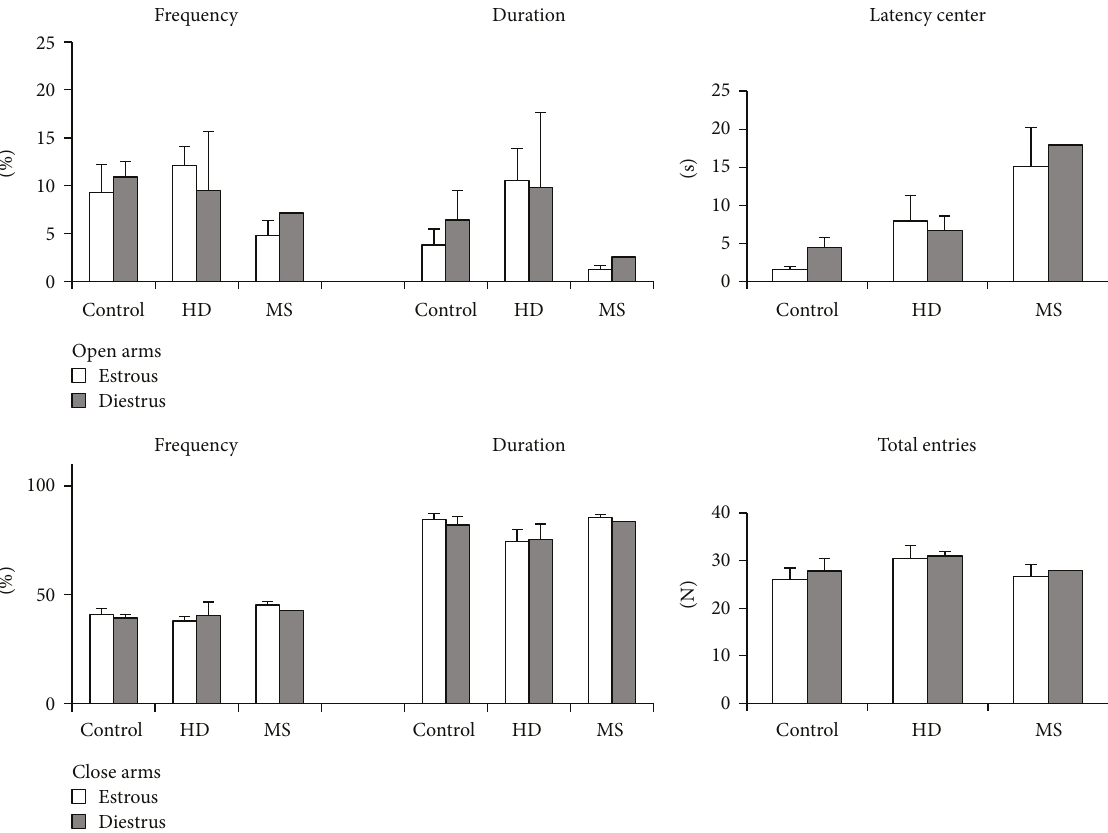
Figure 3: The in fl uence of early-life stress on the behavior of adult female mice in plus-maze test in di ff erent phases of estrous cycle. Data present as mean ± standard error of the mean (SEM). White box: estrous (5 female controls, 4 HD group, and 6 MS group), gray box: diestrus (6 female controls, 2 HD group, and 1 MS group). Insu ffi cient number of mice in each phase did not allow a correct statistical